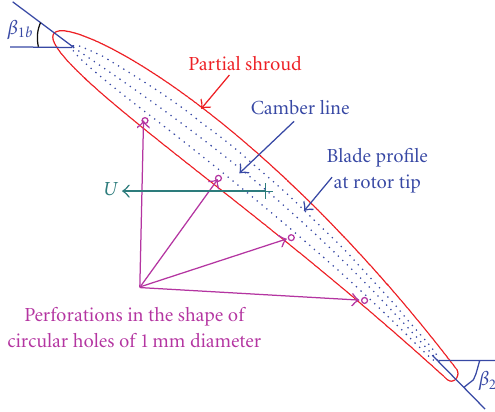
Figure 3: Rotor Blade Tip Profile with Partial Shroud.